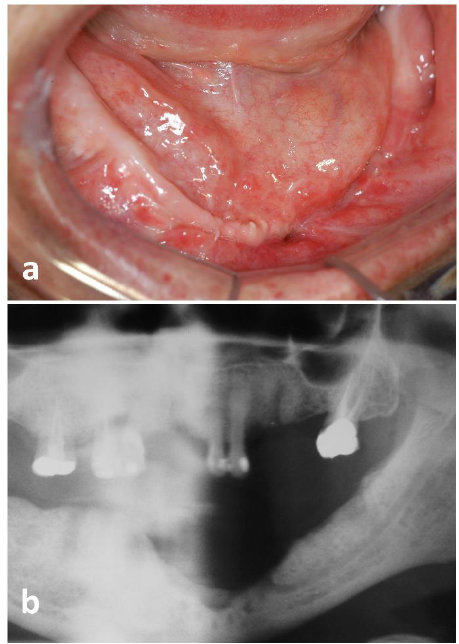
Figure 1. Clinical features of mandibular Aspergillus osteomyelitis. ( a ) Oral fistula and diffuse swelling on the lower left alveolar ridge. ( b ) Radiographic aspect, showing marginal bone resorption with poorly defined borders caused by Aspergillus infection in the mandible.